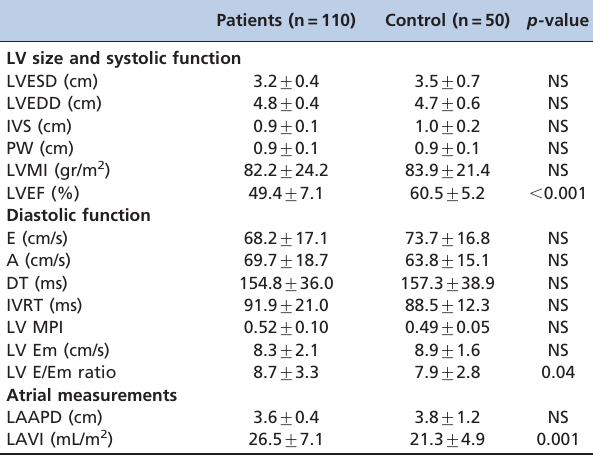
Table 3 - Echocardiographic measurements of the study population. Data are the mean ¡ standard deviation.